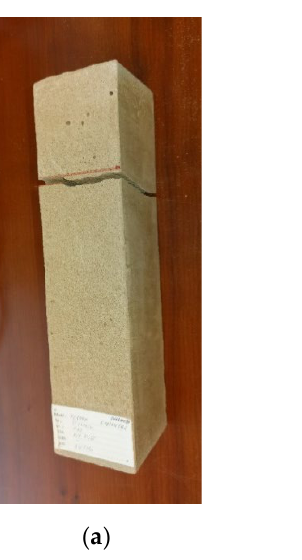
Figure 14. FC specimen 35030420 – unclamped: ( a ) cross - section view of the cracked “lines” on the sides of the block; ( b ) surface shape of the cracked area.